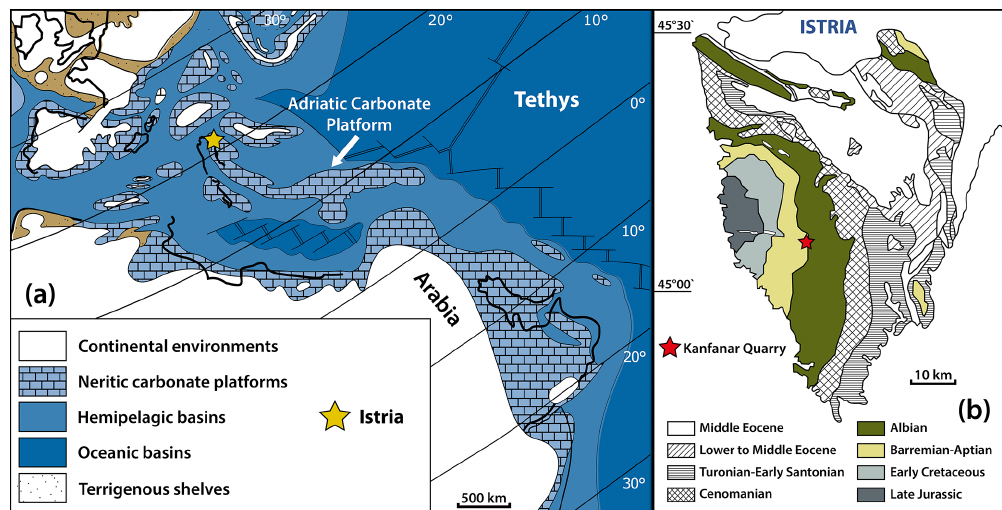
Figure 1. (a) Paleogeographic reconstruction of the early Aptian Tethyan realm (119Ma) displaying the isolated Adriatic Carbonate Platform surrounded by hemipelagic basins (approximate position of Istria is indicated with a yellow star; modified after Masse et al., 2004, and Huck et al., 2010). (b) Regional geology of Istria with the location of the Kanfanar quarry (modified after Huck et al., 2010).